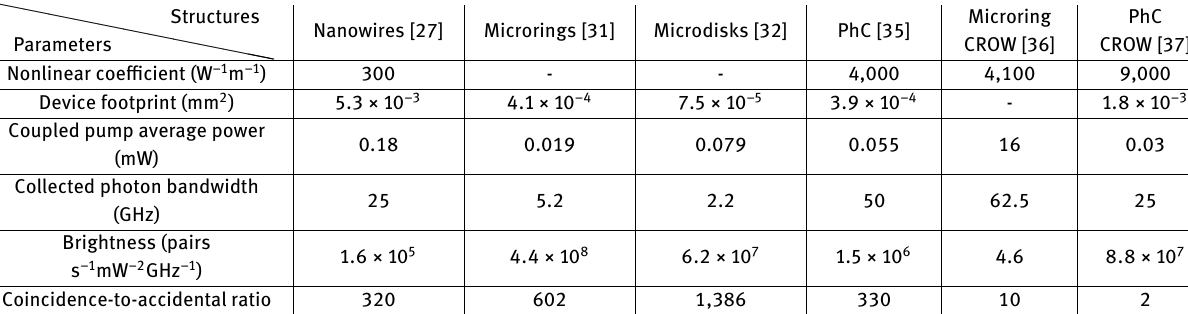
Table 1. Summary of typical experimental results in different silicon structures.